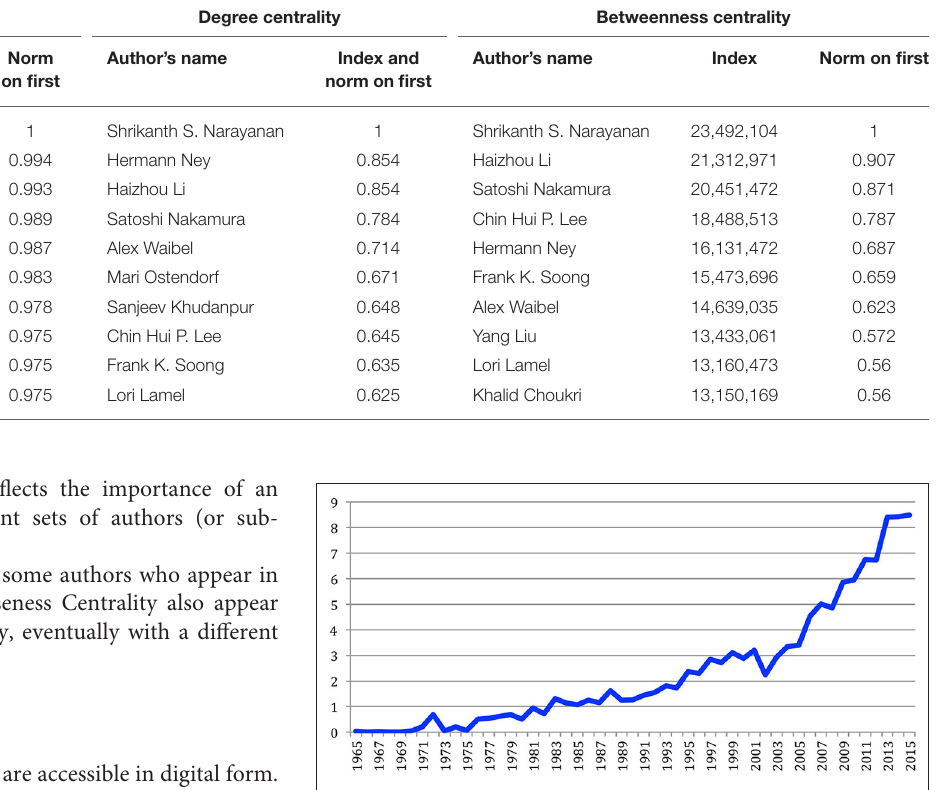
FIGURE 36 | Average number of references per paper over the years.